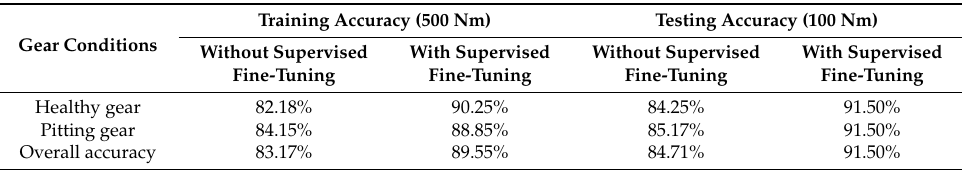
Table 9. Detection results of DNN at mixed rotating speeds (trained with heavy loading samples and tested with light loading